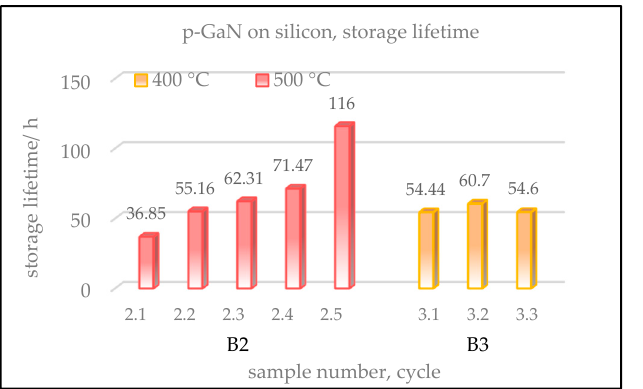
Figure 11. Storage lifetimes of p-GaN:Cs on silicon photocathodes. Sample descriptions are the same as in Figure 10.